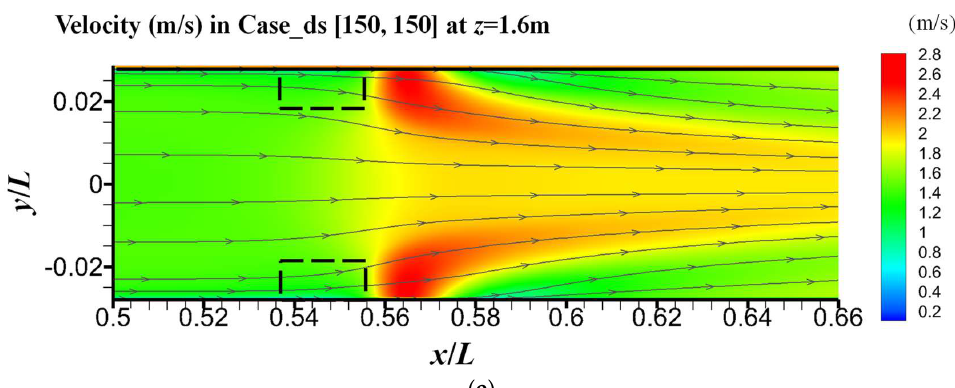
Figure 5. Velocity magnitude with streamtrace on horizontal cross section from 135 m ( x/L = 0.5) to 178 m ( x/L = 0.66) at pedestrian level ( z = 1.6 m). ( a ) Base Case; ( b ) Case_sl [150]; ( c ) Case_ss [150]; ( d )